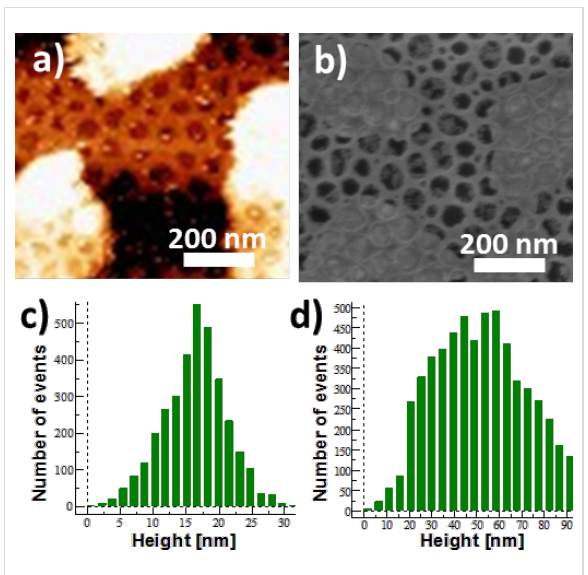
Figure 2: a) AFM and b) SEM images of the sample Au10NC . Depth distribution histogram in the c) dark and d) light areas.